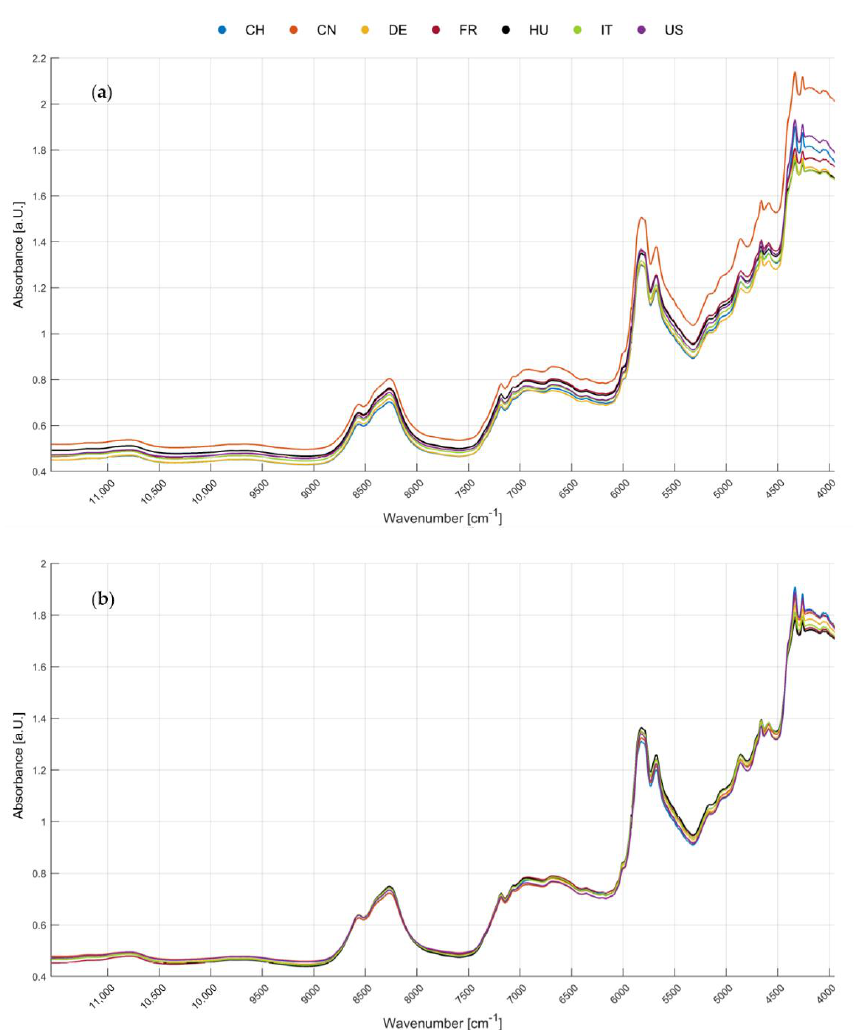
Figure 2. Mean spectra of the seven analyzed walnut origins in a wavenumber range of Figure2. Meanspectraofthesevenanalyzedwalnutoriginsinawavenumberrangeof11,550–3950cm − 1 : 11,550 – 3950 cm – 1 : ( a ) prior to further pre-processing; ( b ) MSC-corrected. ( a ) prior to further pre-processing; ( b ) MSC-corrected.